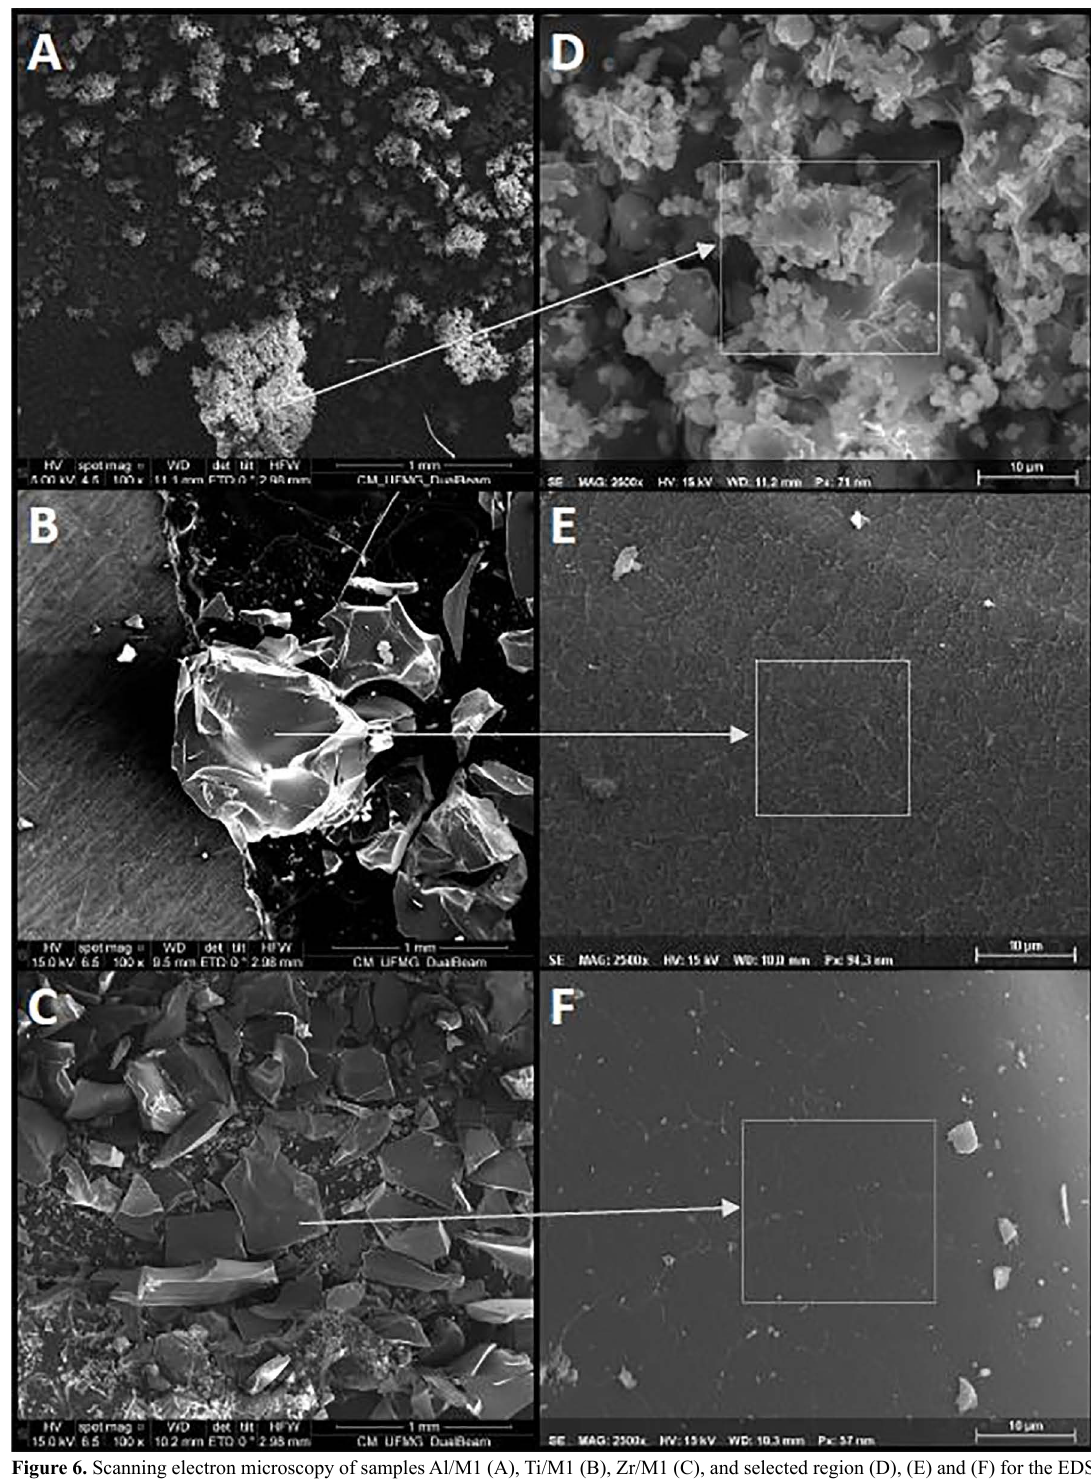
Figure 6. Scanning electron microscopy of samples Al/M1 (A), Ti/M1 (B), Zr/M1 (C), and selected region (D), (E) and (F) for the EDS technique fof samples (A), (B) and (C),